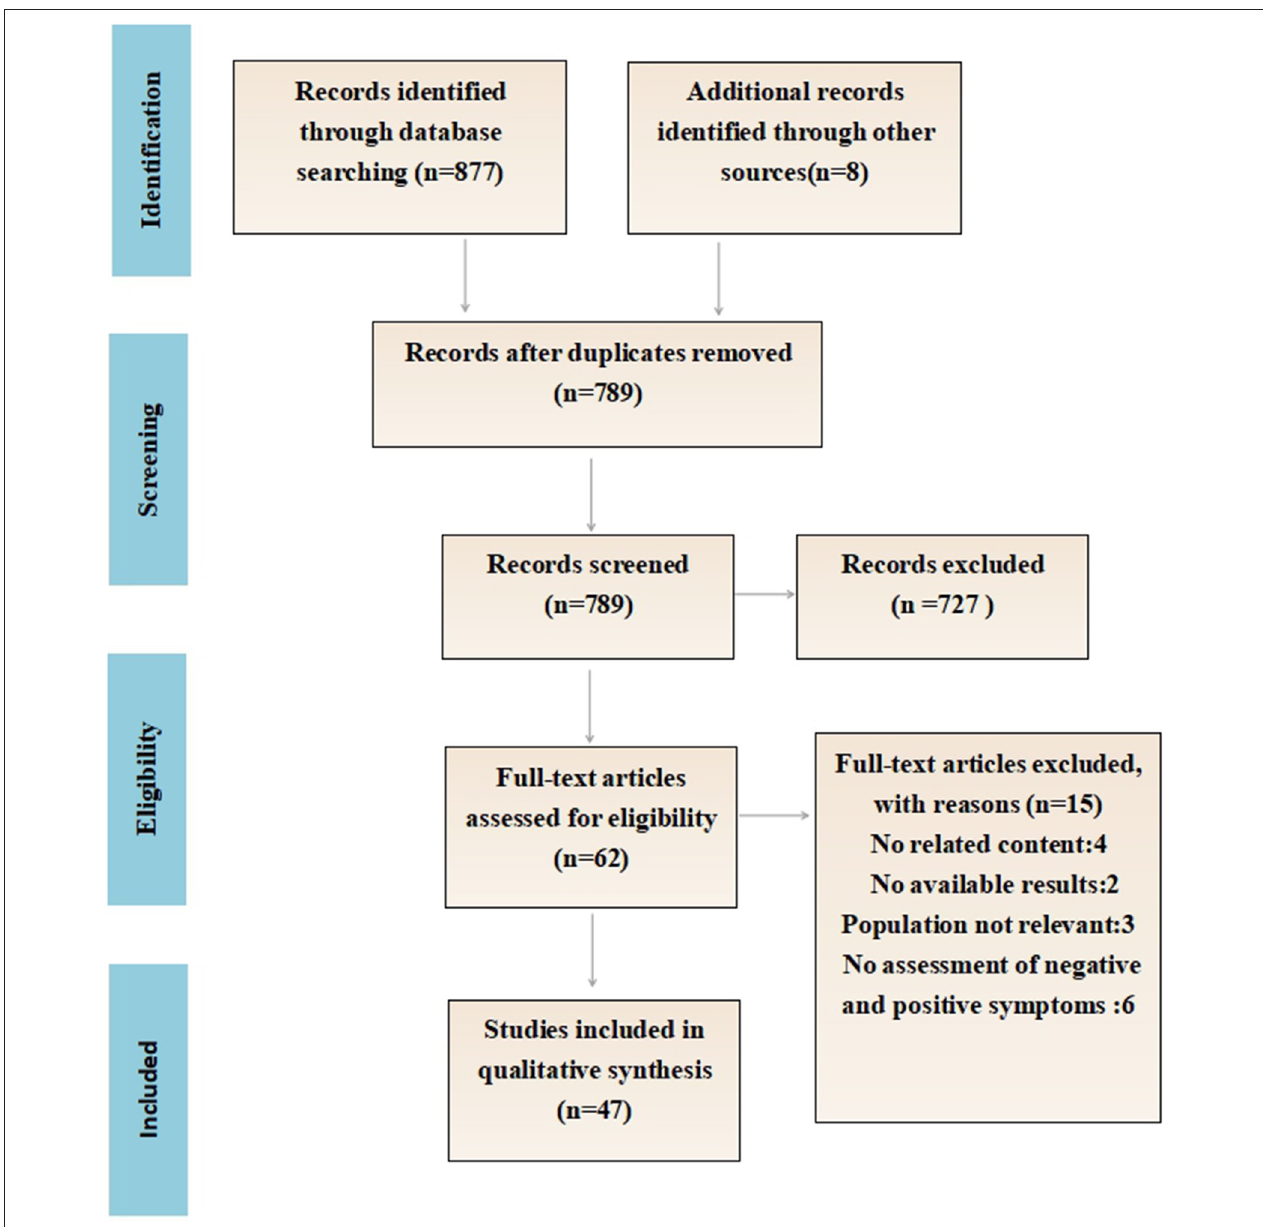
FIGURE 1 | Search strategy and